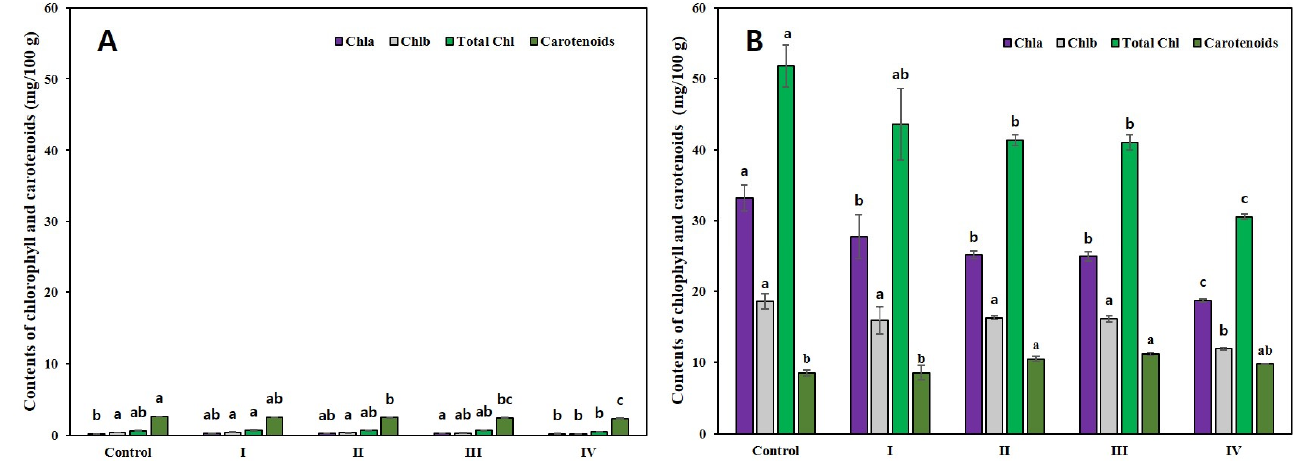
Figure 3. Chlorophyll and carotenoid contents (mg/100 g dry weight) in Satsuma mandarin fruit ( A ) pulp and ( B ) peel, according to the degree of sunburn severity. The values representing different alphabets are statistically significant ( p < 0.05).